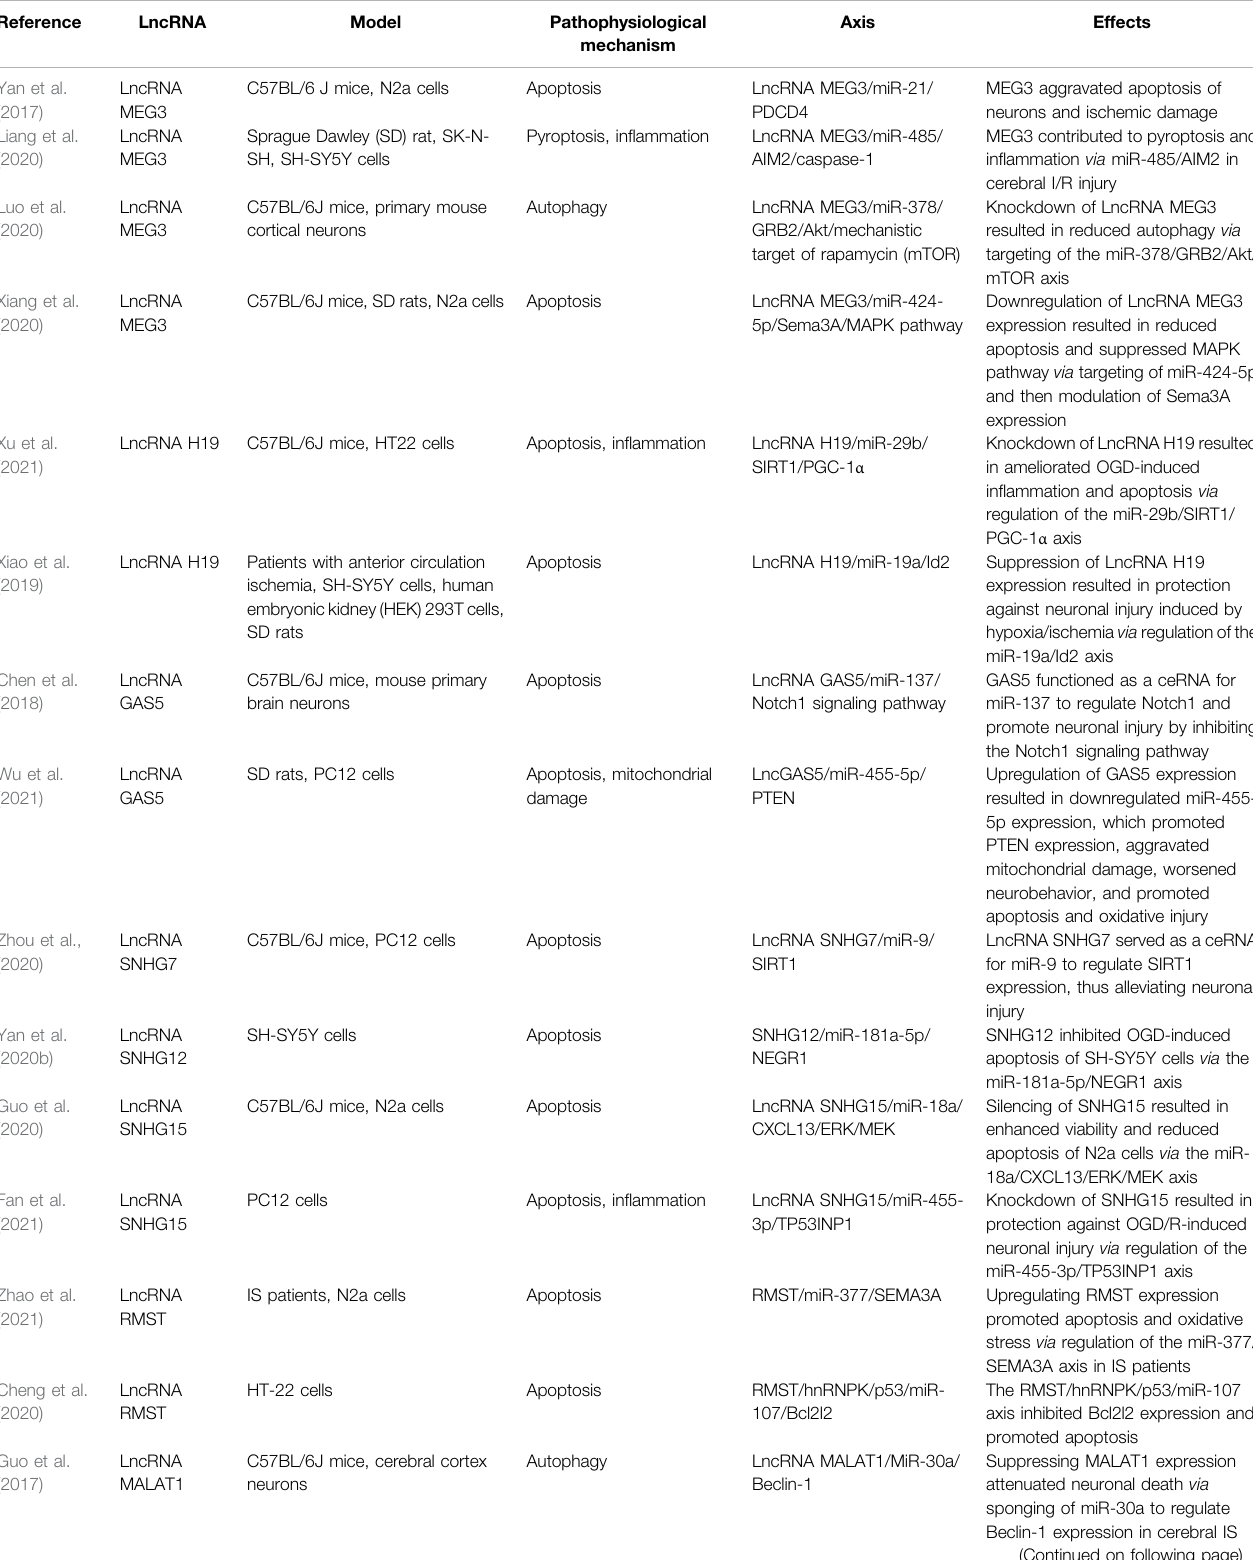
TABLE 1 | Studies evaluating LncRNA-mediated ceRNA networks in